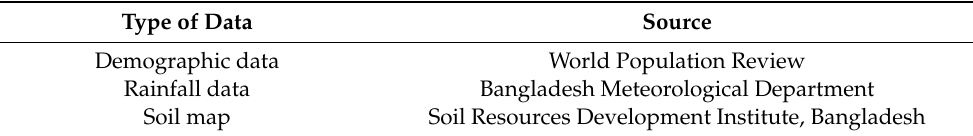
Table 2. Specifications of other data used.